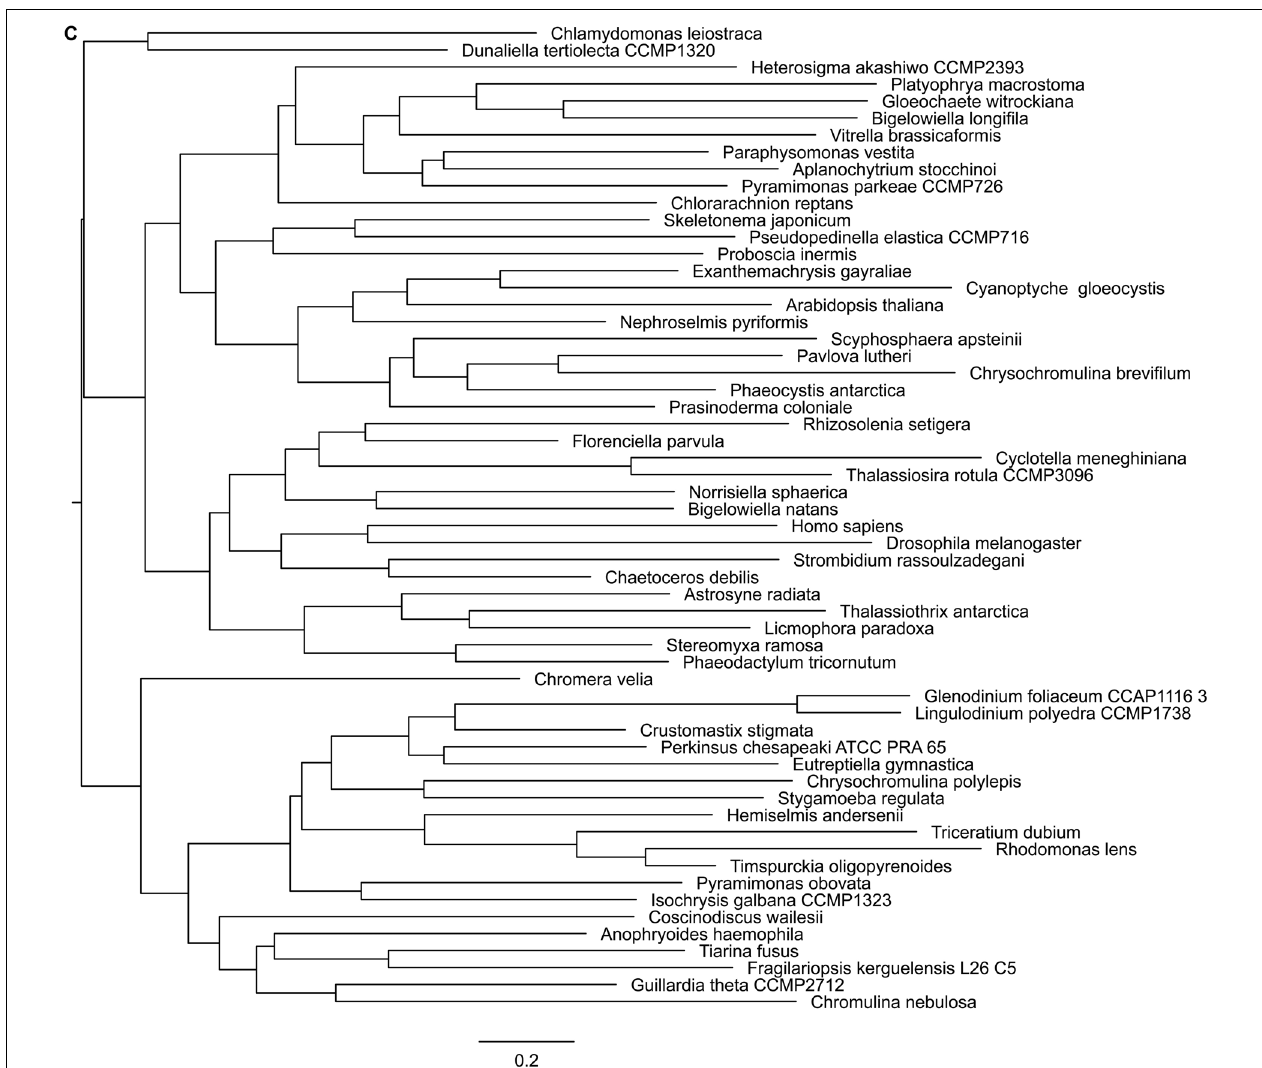
FIGURE 3C | Phylogenetic trees of PRC2 components. (A) Enhancer of zeste, (B) ESC, (C) Su(z)12.